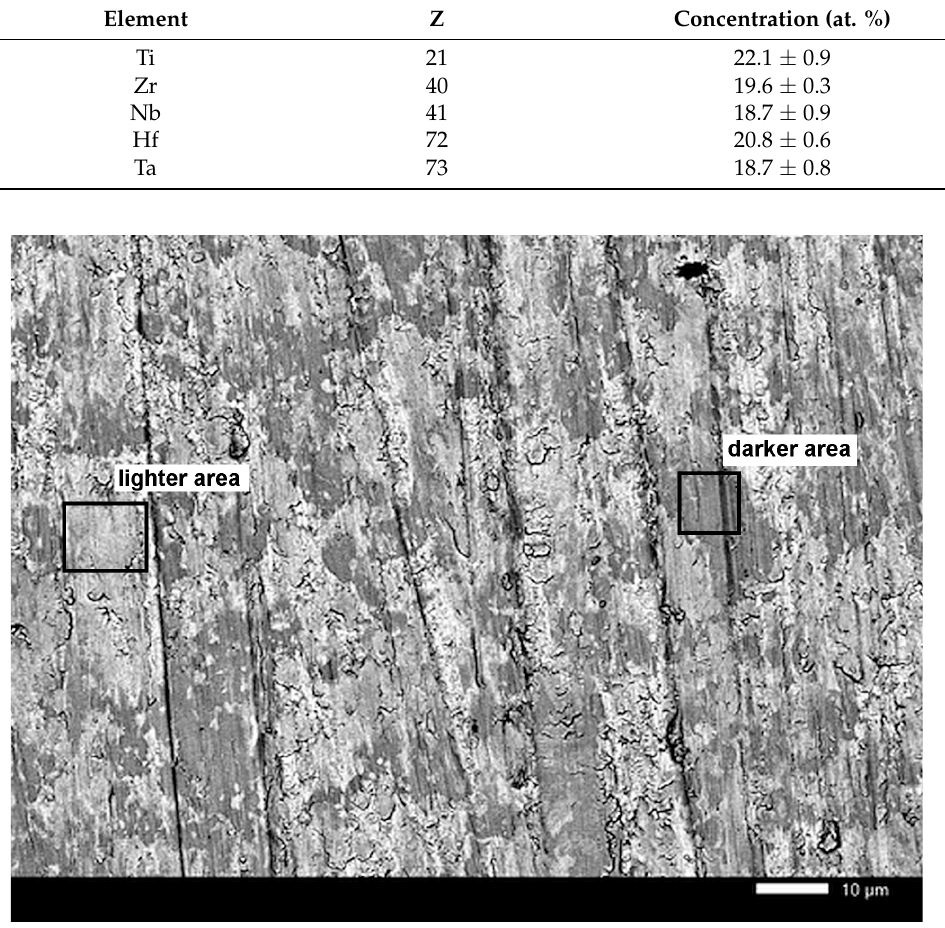
Figure 6. SEM micrograph of the ground deposition target surface; 10 kV, back-scattered electrons, magnification 1000×; the presence of “light” and “dark” structural domains is apparent; the straight scratch- lines are caused by the applied grinding process. Table 4. Elemental composition observed by EDXS on a pair of the “light” and “dark” structural domains shown in Figure 6; the oxygen content is included. Concentration, Darker Element Domain (at.